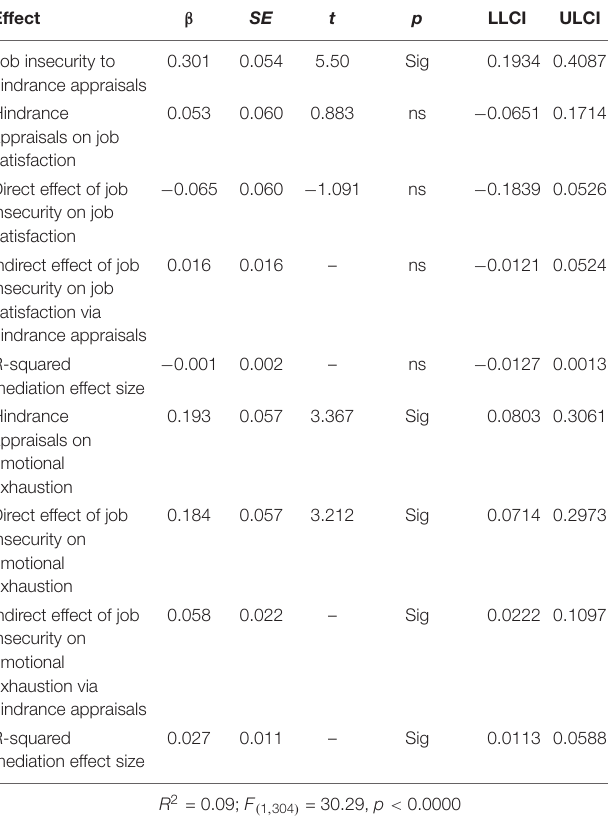
TABLE 4 | Regression results (standardized regression coefficients) predicting the outcomes ( N =